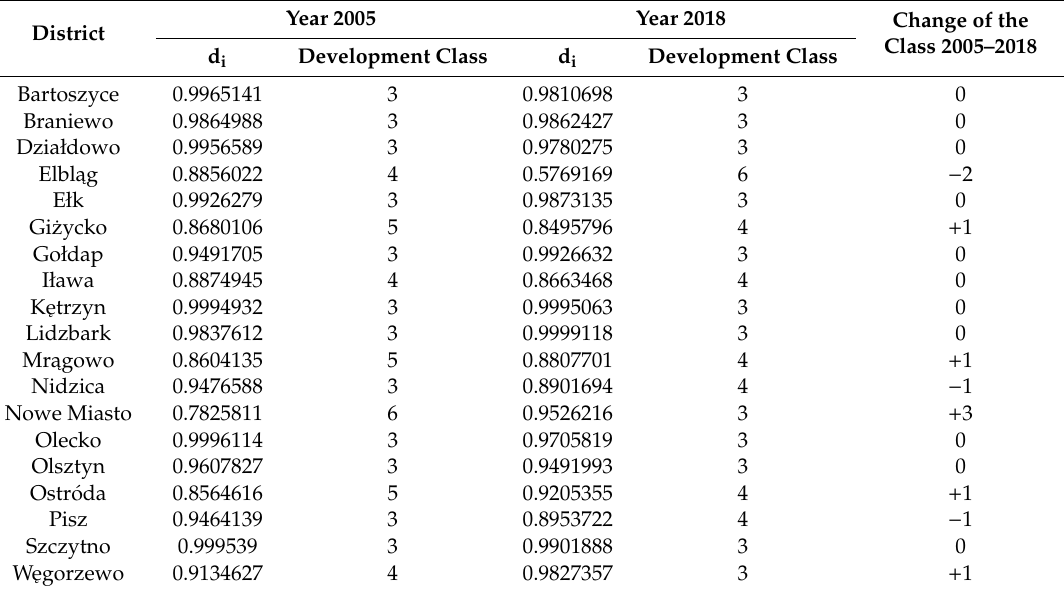
Table 2. Determining the level of social development for the analyzed